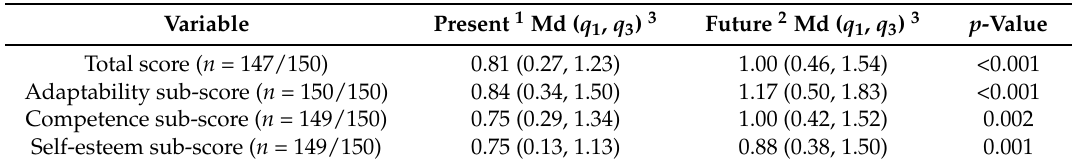
Table 1. PIADS total scores and sub-scores for eHealth services in the present and the future.